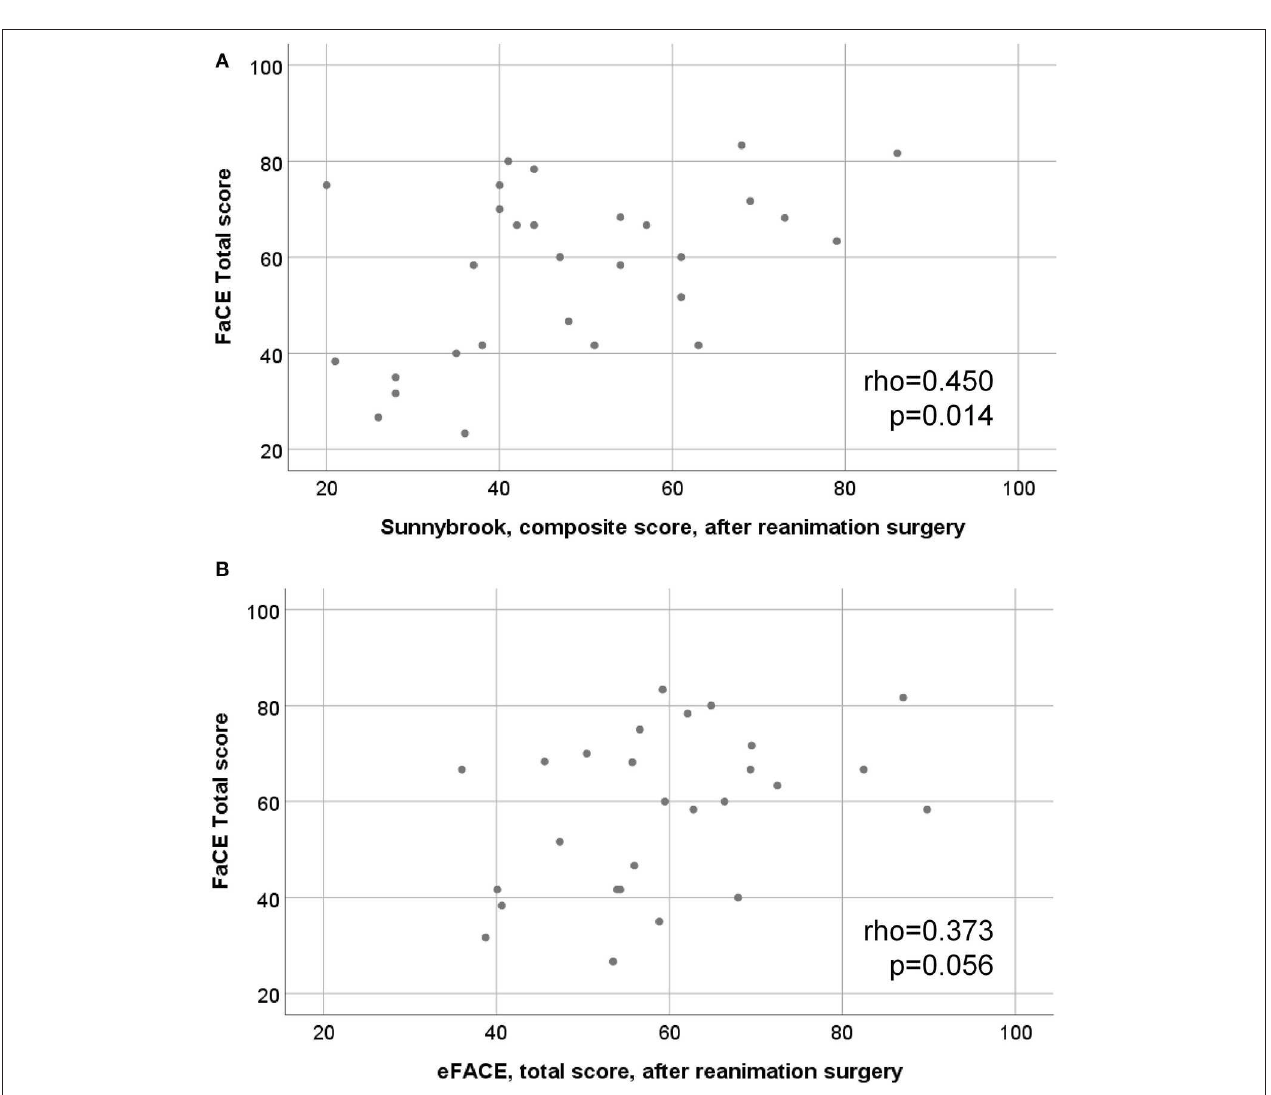
FIGURE 3 | Scatter plots of the relation between motor function and quality of life assessments. (A) final Sunnybrook grading, composite score, after hypoglossal-facial jump nerve suture (x-axis) vs. the FaCE total score (y-axis). (B) final eFACE, total score grading after hypoglossal-facial jump nerve suture (x-axis) vs. the FaCE total score